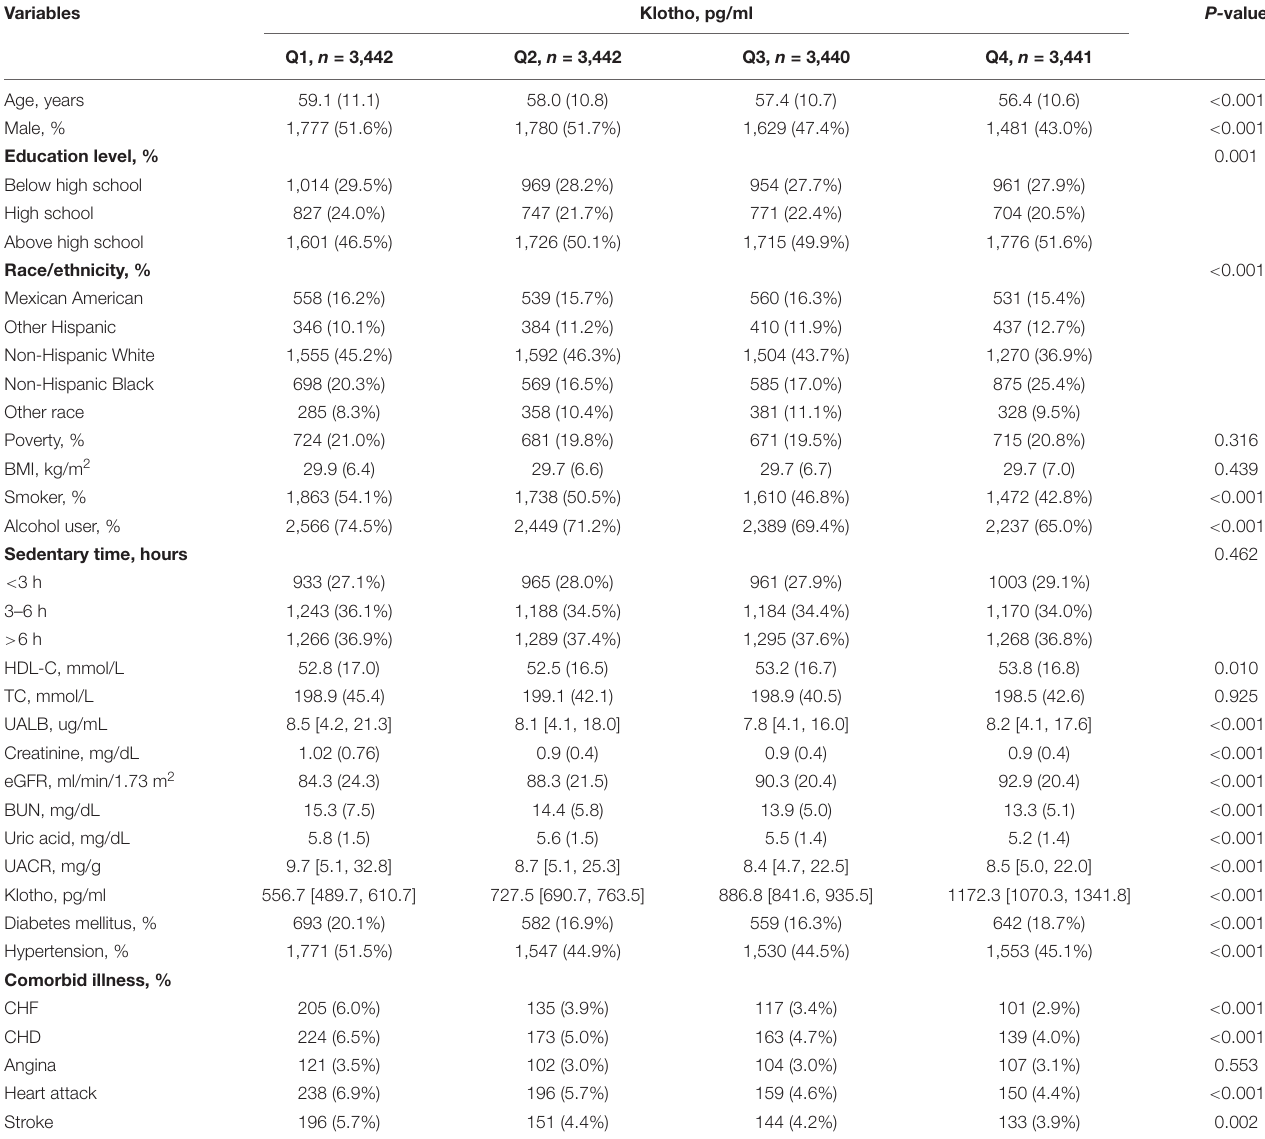
TABLE 1 | Characteristics of the study